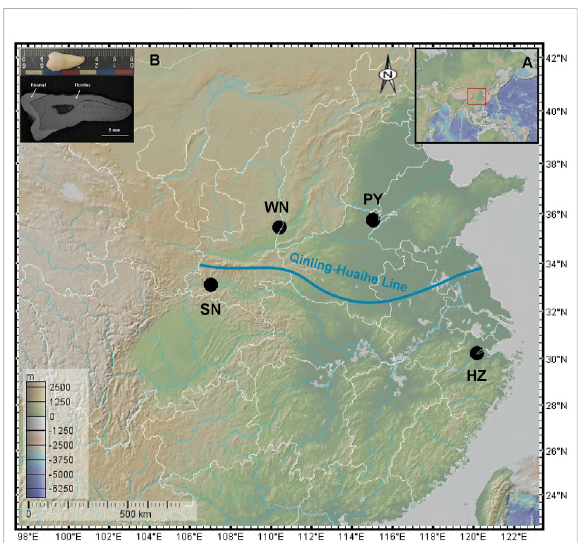
FIGURE 1 (A) Location of the sampling sites. WN-Weinan, PY-Puyang, SN-SouthernShaanxiregions, HZ-Hangzhou. (B) Themorphology of a tooth sample and Back-scattered electron image of a tooth sample